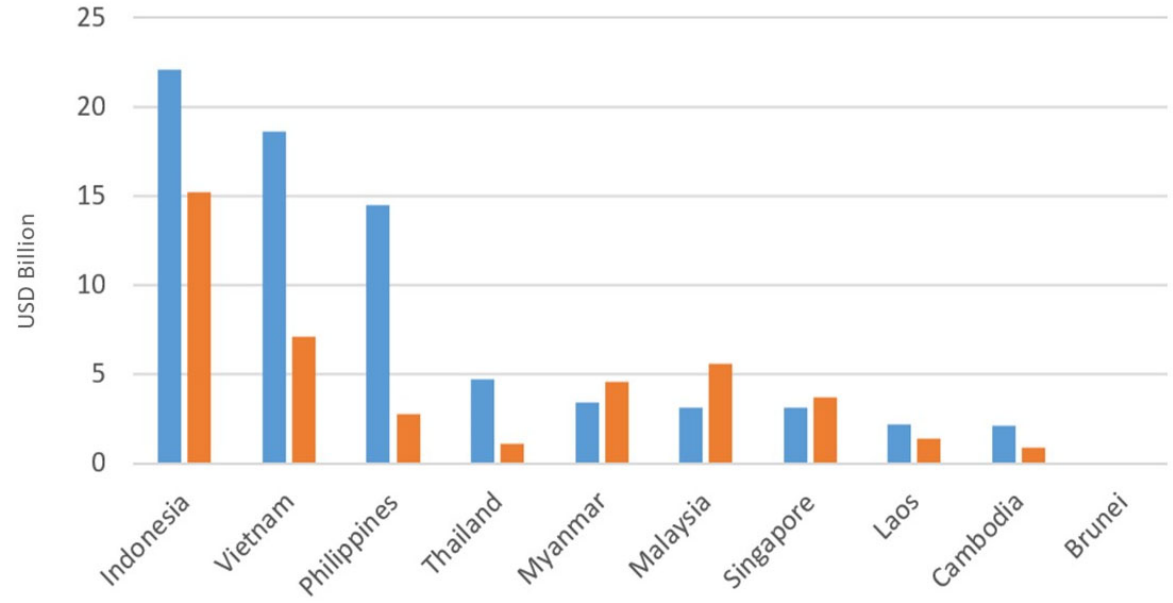
Figure 1. International project finance values (annual averages during 2015–2017 (blue bar) and 2018–2020 (orange bar) in USD billion) of ASEAN countries. Developed from [12].